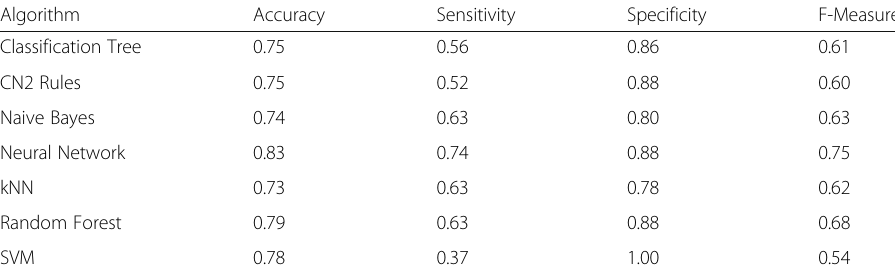
Table 5 Data Transformation: Equal Frequency, Feature Selection: None Algorithm